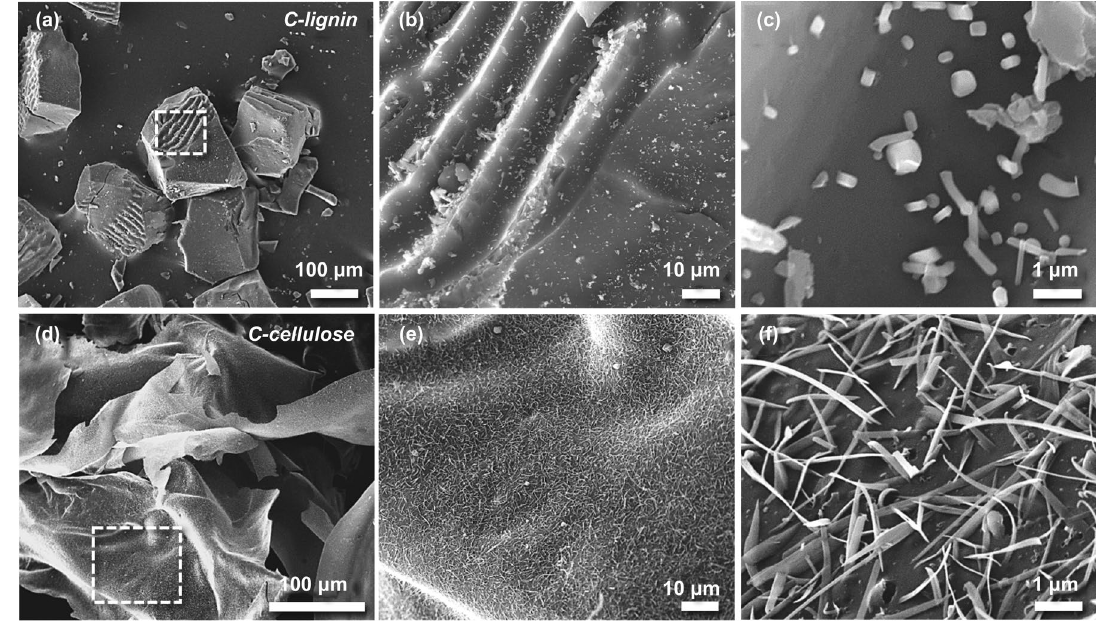
Fig. 3 Morphology of carbonized lignin and cellulose. a – c SEM images of C-lignin. d – f SEM images of